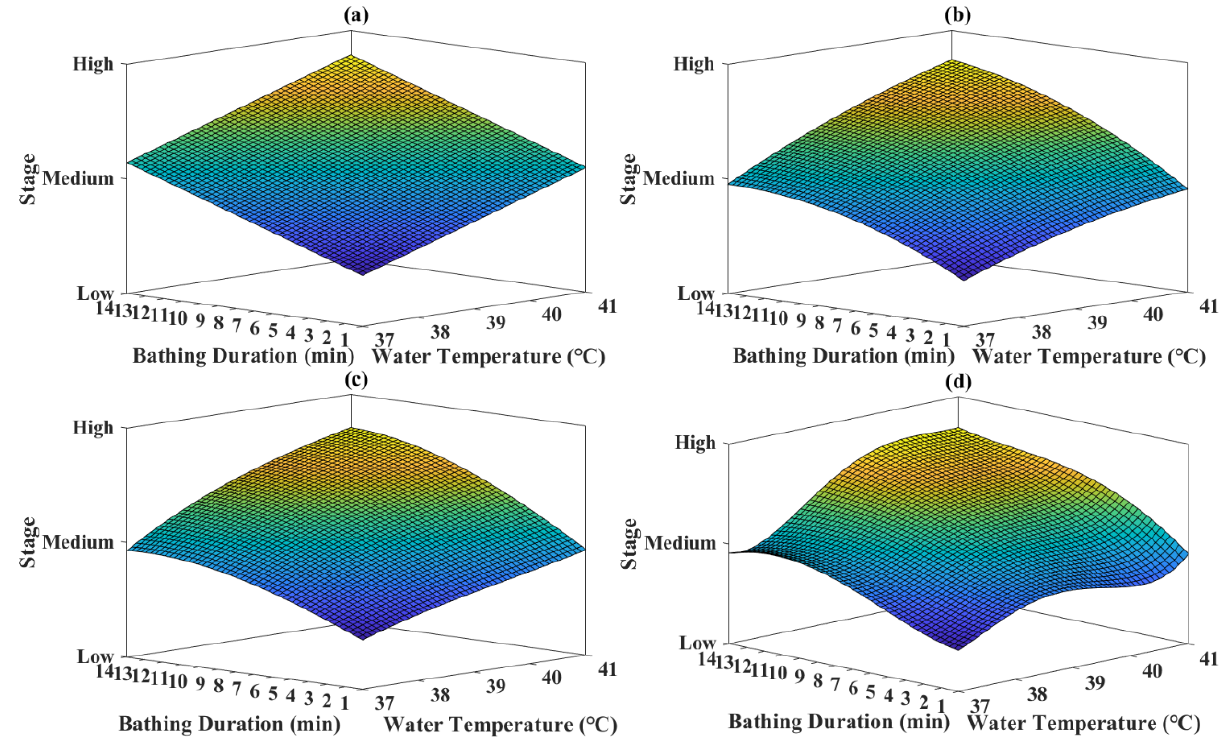
Figure 9. Relationship surfaces using polynomial fitting. ( a – d ) First to fourth order polynomials, respectively, are implemented.